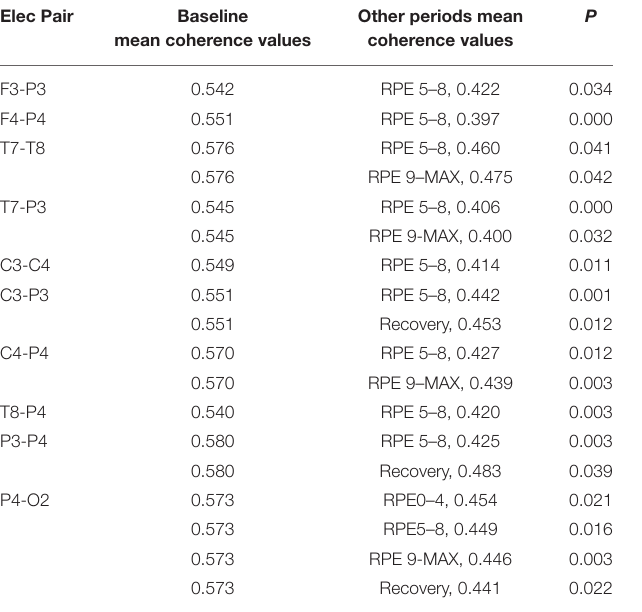
TABLE 2 | Post-hoc pairwise comparisons on effort level in alpha band.